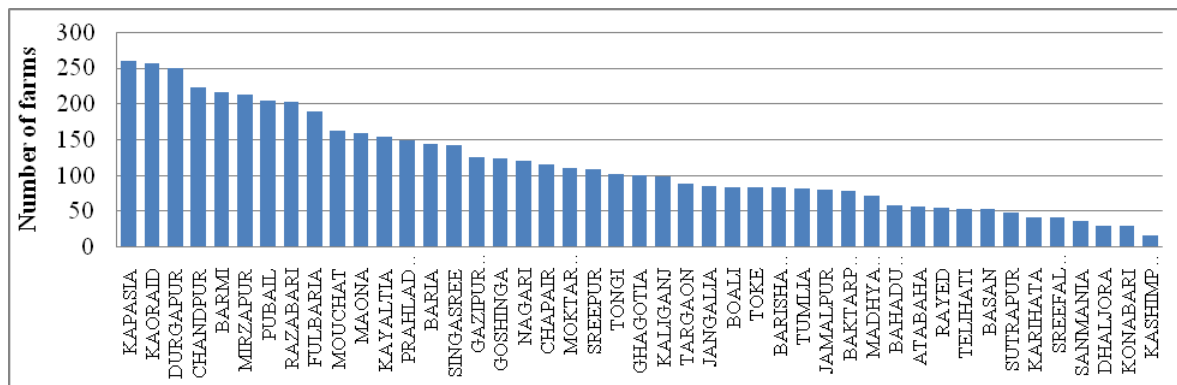
Figure 7. Rankings of administrative unions by the numbers of poultry farms/microenterprises in Gazipur.